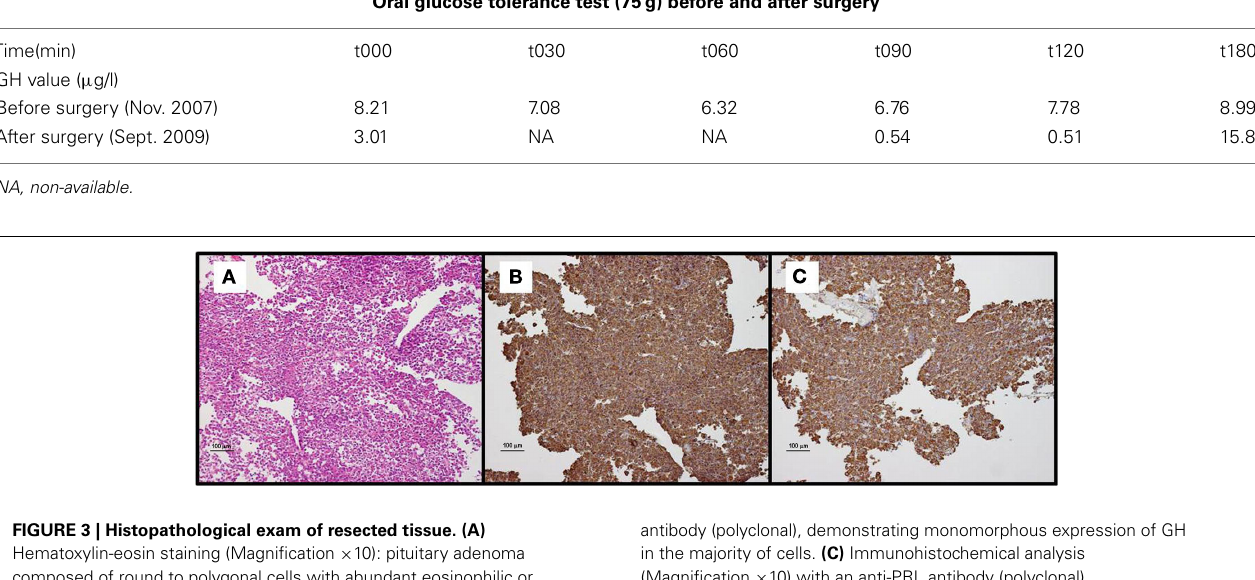
antibody (polyclonal), demonstrating monomorphous expression of GH in the majority of cells. (C) Immunohistochemical analysis (Magnification × 10) with an anti-PRL antibody (polyclonal), demonstrating monomorphous expression of PRL in the majority of